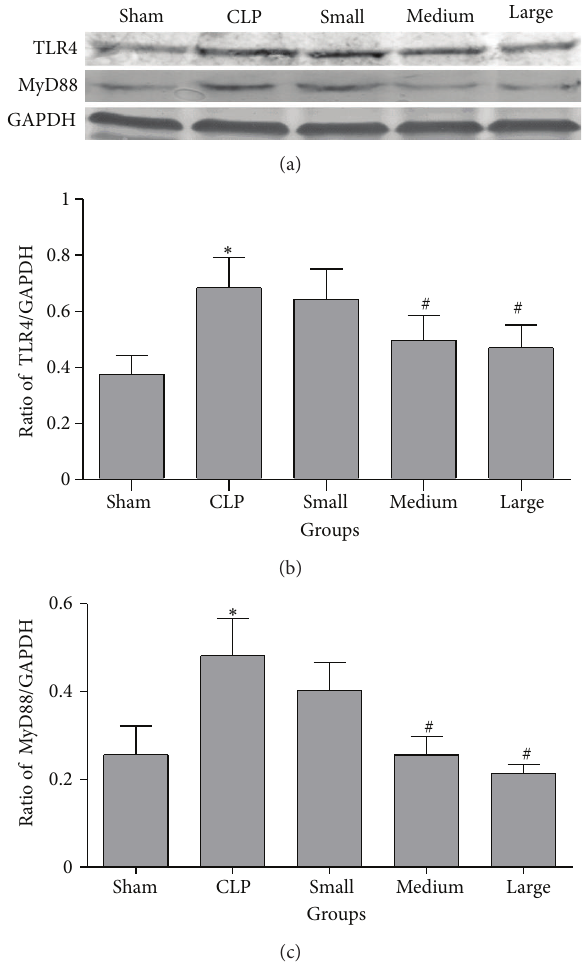
Figure 5: Effect of dexmedetomidine on TLR4 and MyD88 expression in lung tissues of septic rats by western blotting.